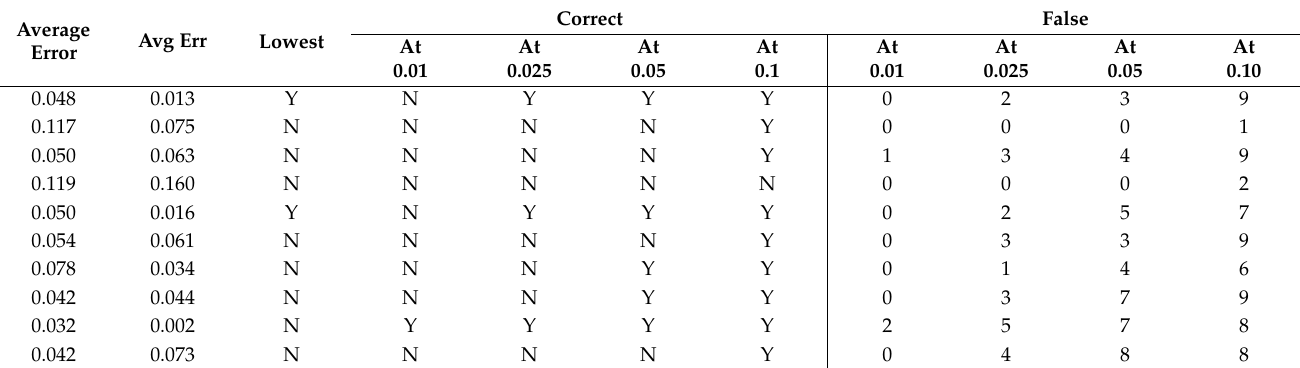
Table A107. Set 2, trials 11–20 data (single 0.5 PR value).